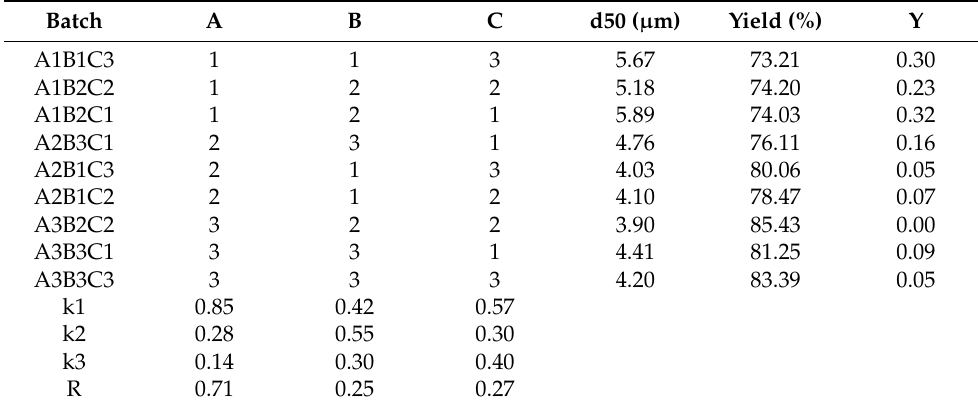
Table 2. Results of the orthogonal test for optimization.